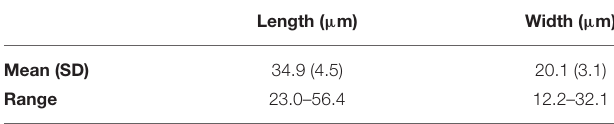
TABLE 1 | Number of C. subsalsa blooms with > 0.1 × 10 6 cells L − 1 and > 0.5 × 10 6 cells L − 1 in five zones of Guanabara Bay as shown in the map of Figure 1 .